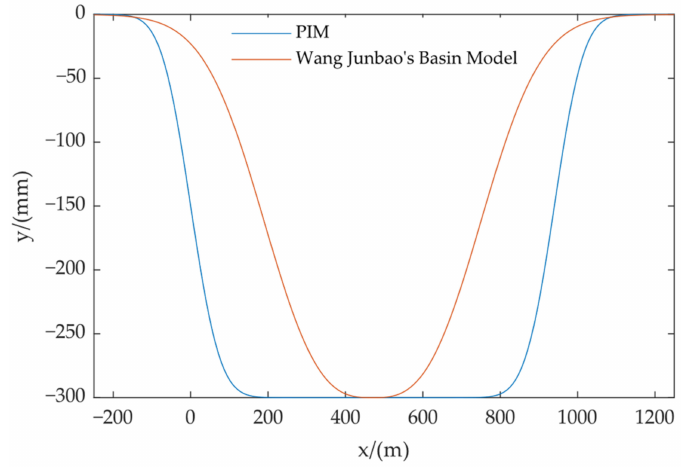
Figure 6. Comparisons of the main profiles of the strike in a subsidence basin.